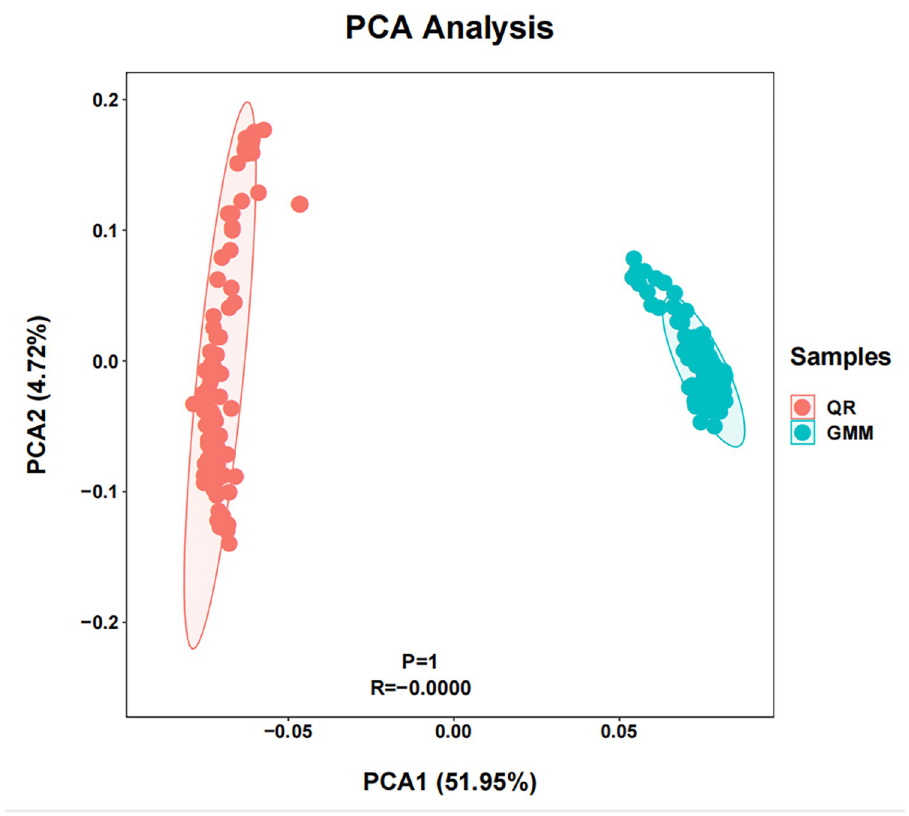
Fig 2. PCA group results of Qira Black sheep and German Merino sheep. Note: The red part (QR) is Qira Black sheep; The green part (GM) is German Merino sheep.